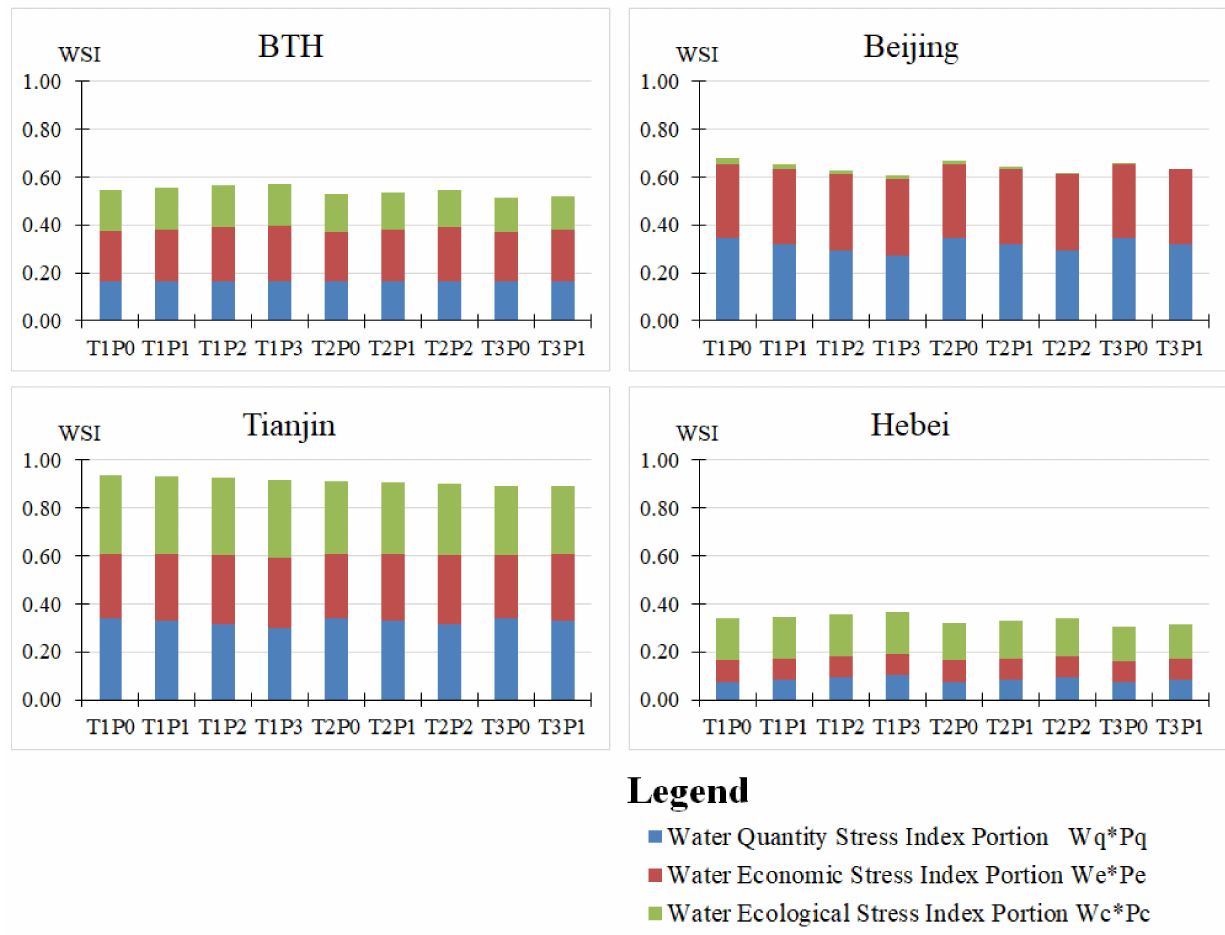
Figure 7. Water stress index in different